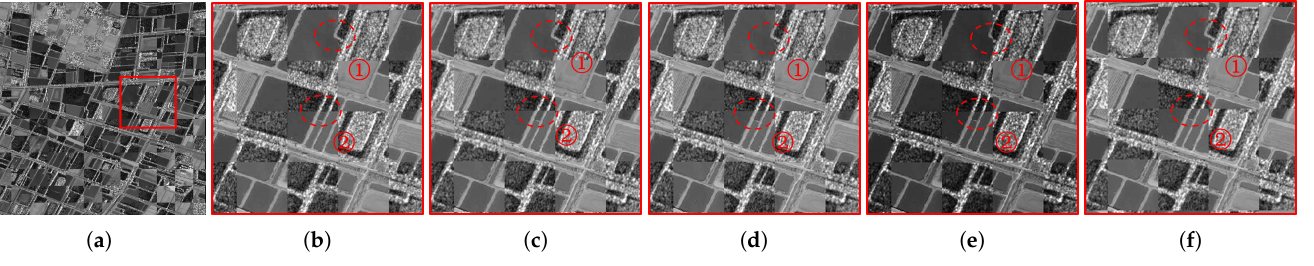
Figure 20. Checkboard mosaic image and enlarged sub-images of Pair C: ( a ) checkboard mosaic image of HOPES; ( b – f ) enlarged sub-images of HOPES, CFOG, HOPC, SAR-SIFT, OS-SIFT.